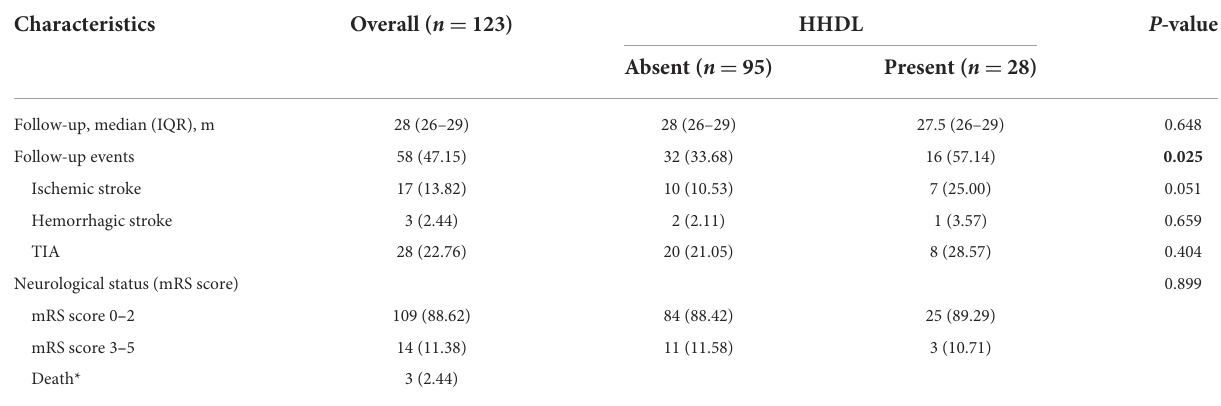
TABLE 3 Long-term outcomes of the participants with and without